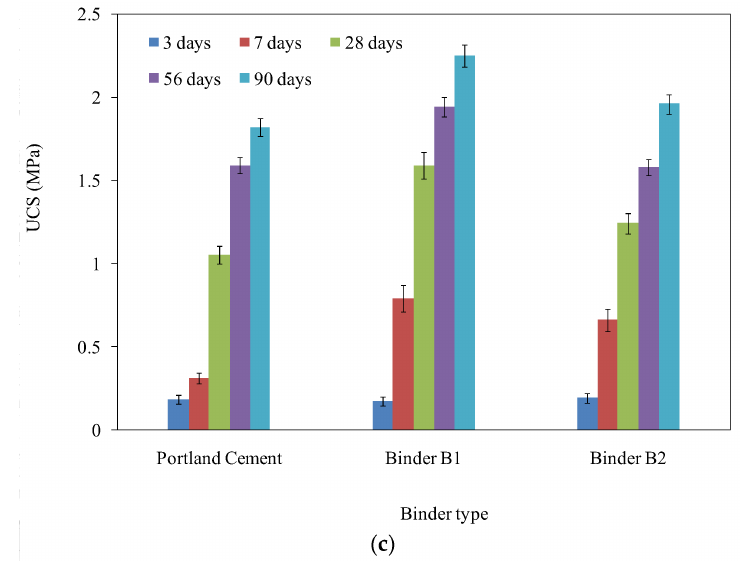
Figure 5. The effect of the binder type on the UCS of CTB samples with solid content of 65 wt %. ( a ) 1:4 binder/tailings ratio; ( b ) 1:6 binder/tailings ratio; ( c ) 1:8 of binder/tailings ratio.